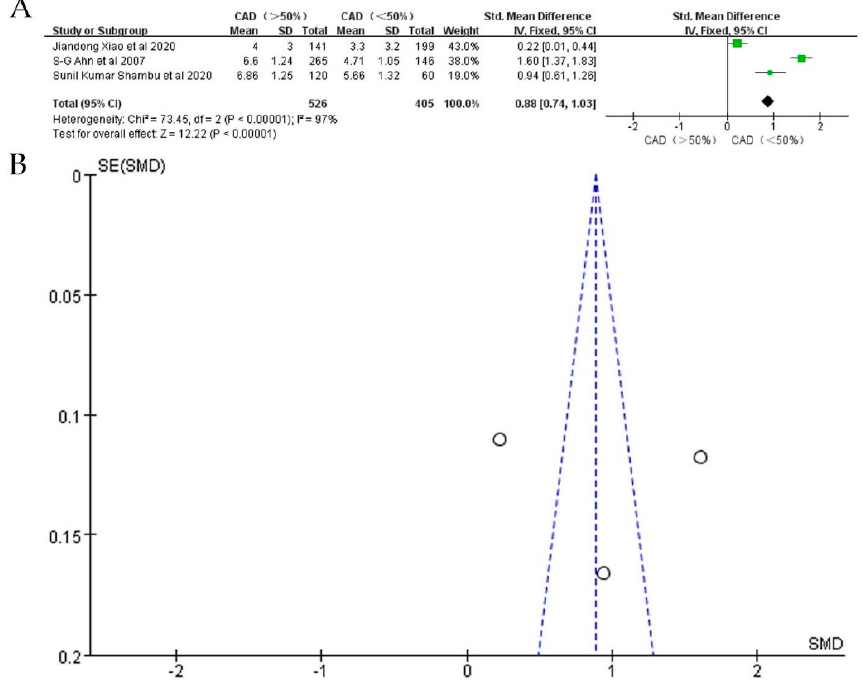
Figure 6. SMD of EAT thickness between patients with severe CAD and mild/moderate CAD. ( A ): Forest plot; ( B ): funnel plot.